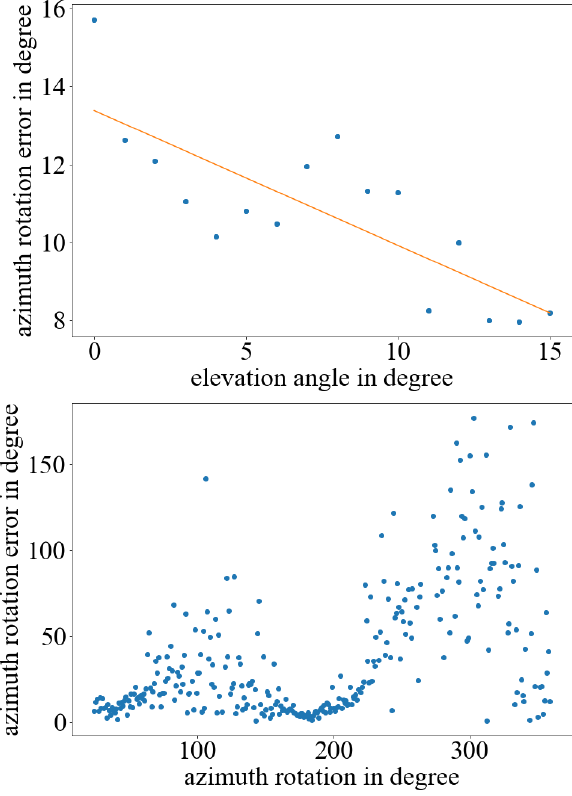
Figure 6. Median azimuth rotation error with respect to Figure 7. Median azimuth rotation error with respect to the elevation angle (top) and with respect to the azimuth the elevation angle (top) and with respect to the azimuth rotation (bottom) of Waymo-Full for the Full-Waymo test rotation (bottom) of Waymo-CycleGAN for the set Full-Waymo test